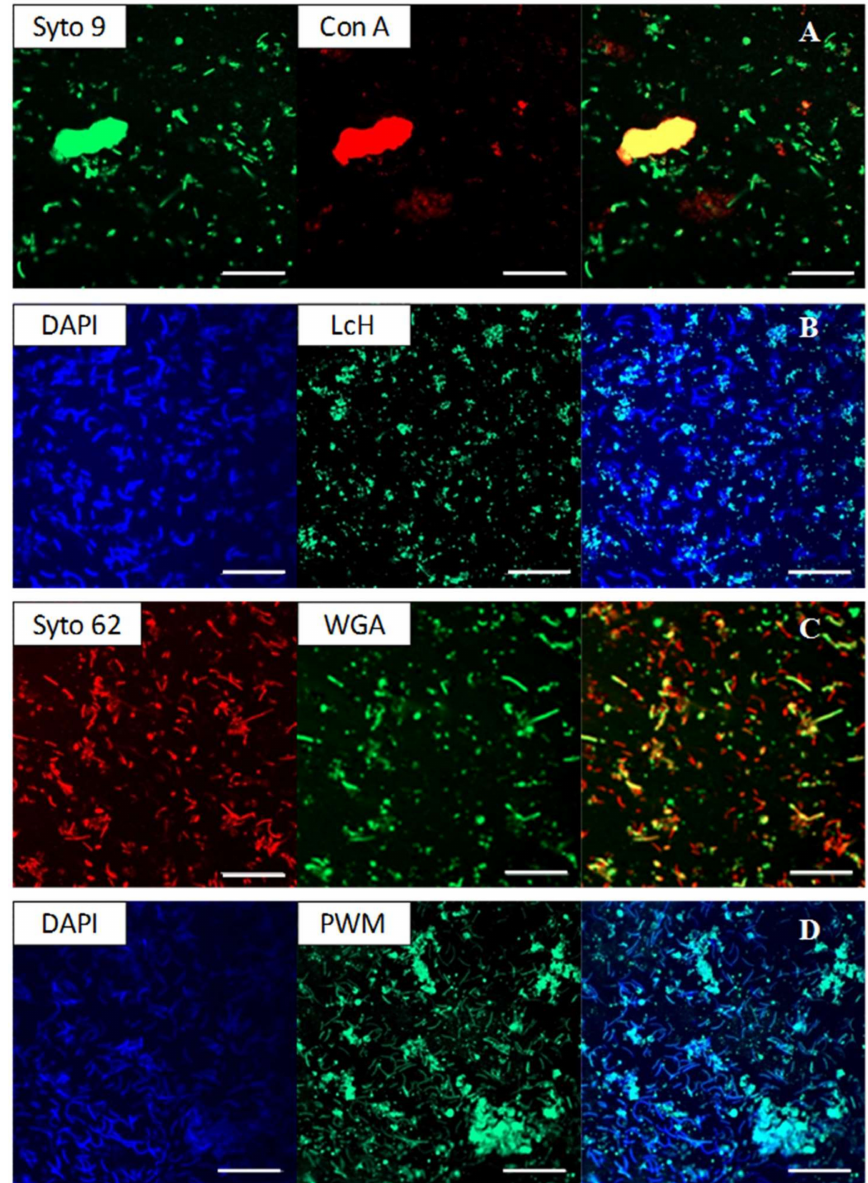
Figure 6. CLSM images of a biofilm region onto gossan mineral stained with different nucleic acid stains to show the distribution of bacterial cells within the biofilm. The region was also stained with several lectins: ( A ) Con A-TRITC, ( B ) LcH-FTIC, ( C ) WGA-FITC, and ( D ) PWM-FTIC. The last column shows the combination of the probes. Scale bars = 10 µ